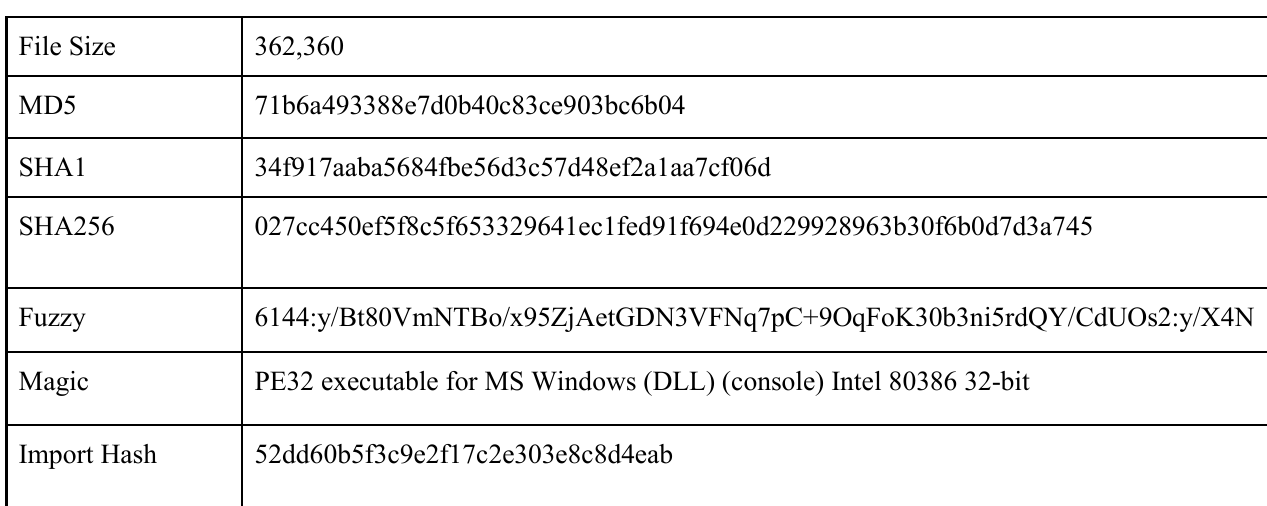
Table 1. Details of Analysed